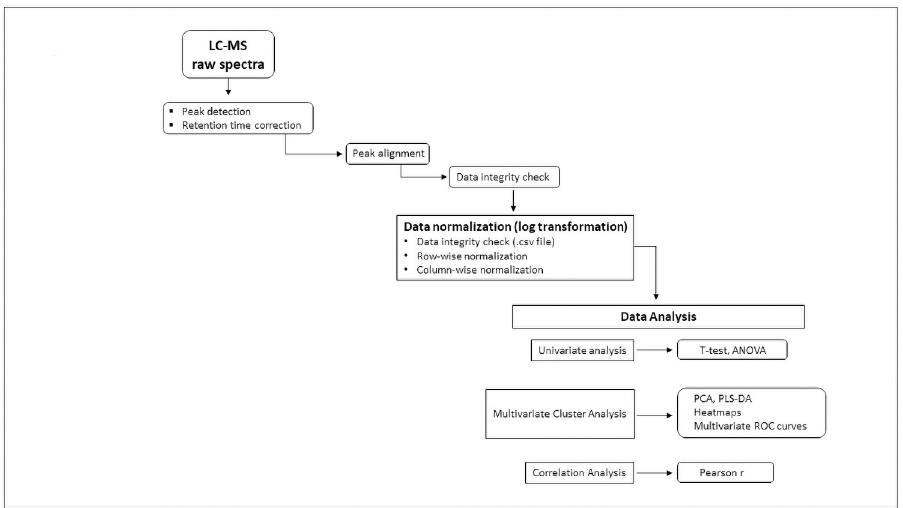
Fig 1. Flowchart illustrating workflow and data processing. Individual metabolite absolute concentrations measured by targeted mass spectrometry (MS/MS) transmitted in.csv data-files were log transformed for normalization and then uploaded into MetaboAnalyst 5.0 bio-informatic data analytic platform. Univariate (t-test, ANOVA), multivariate (PCA, PLS-DA, Heatmaps, Multivariate ROC Curve Analysis) and correlation coefficients (Pearson r) then applied to identify metabolites and ratios associated with